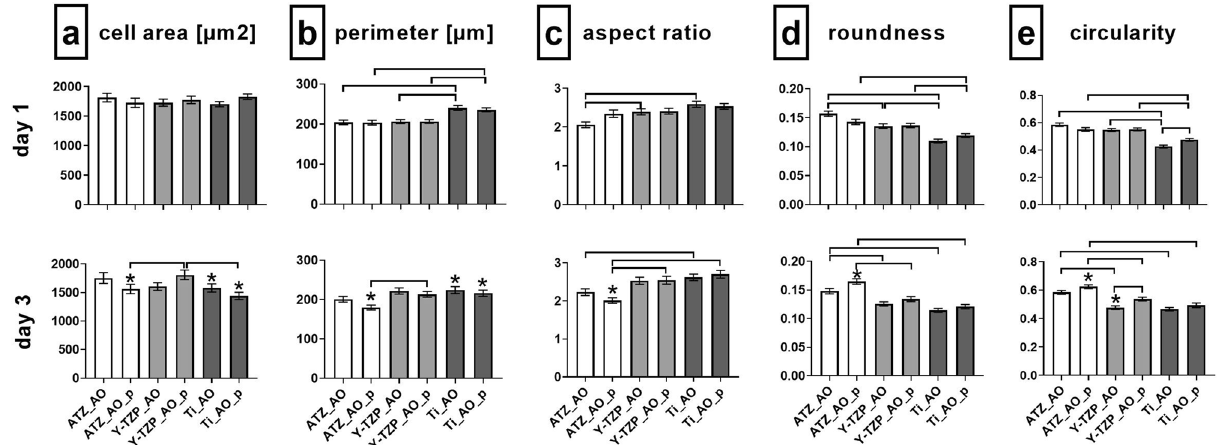
Figure 8. Quantitative morphometric analysis of osteoblast morphology after 1 and 3 days of culture on untreated and plasma-functionalized surfaces. Since the cells had reached confluence at day 7, no morphometric analysis was possible at day 7. Data are presented as mean values (194 < n < 373) ± SEM. Statistically significant differences ( p < 0.05, Dunn´s HSD test) were marked with brackets above the corresponding bars. “*” marks statistically significant differences between day 1 and 3.